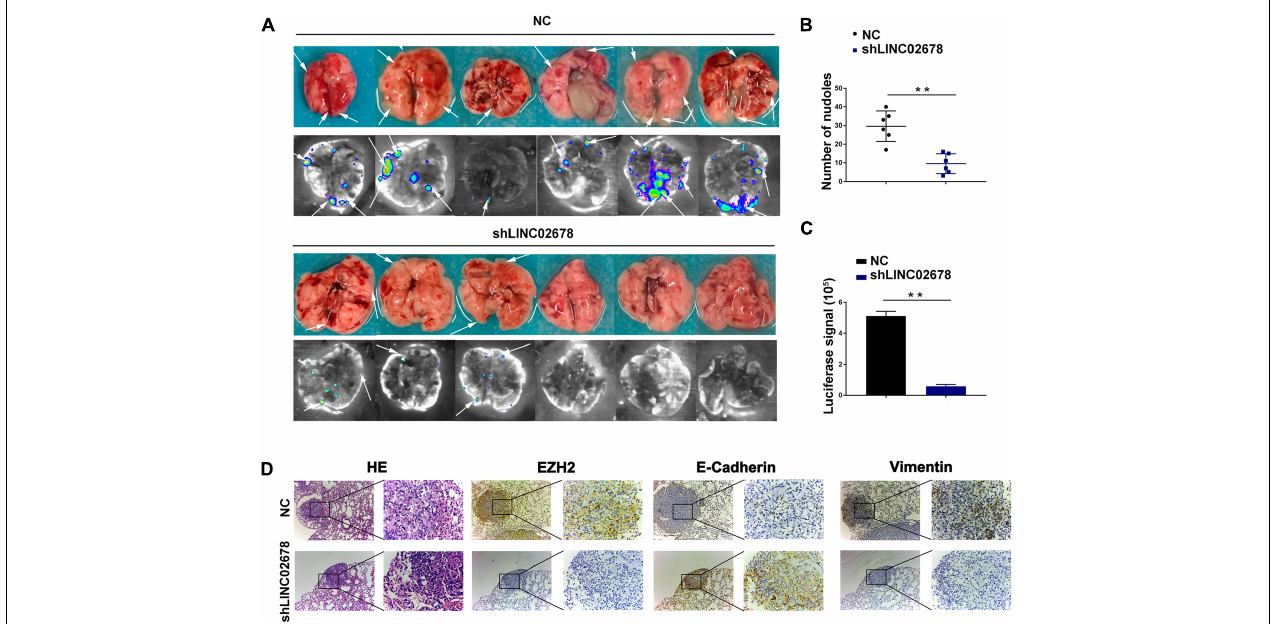
FIGURE 8 | Depletion of LINC02678 repressed tumor metastasis in vivo . (A) Representative bioluminescence images and lung images were monitored at 60 days after injection with luciferase-labeled cells from NC and shLINC02678 groups. (B) Scatter diagram of number of lung metastatic nodules from NC and shLINC02678 groups. (C) Histogram depiction of luciferase signal from NC and shLINC02678 groups. (D) Representative images of the HE and immunohistochemical staining of E-cadherin, vimentin and EZH2 in nude mice lung metastasis sections (magnification, × 100 and × 400). (** p < 0.01. Data were obtained from three independent